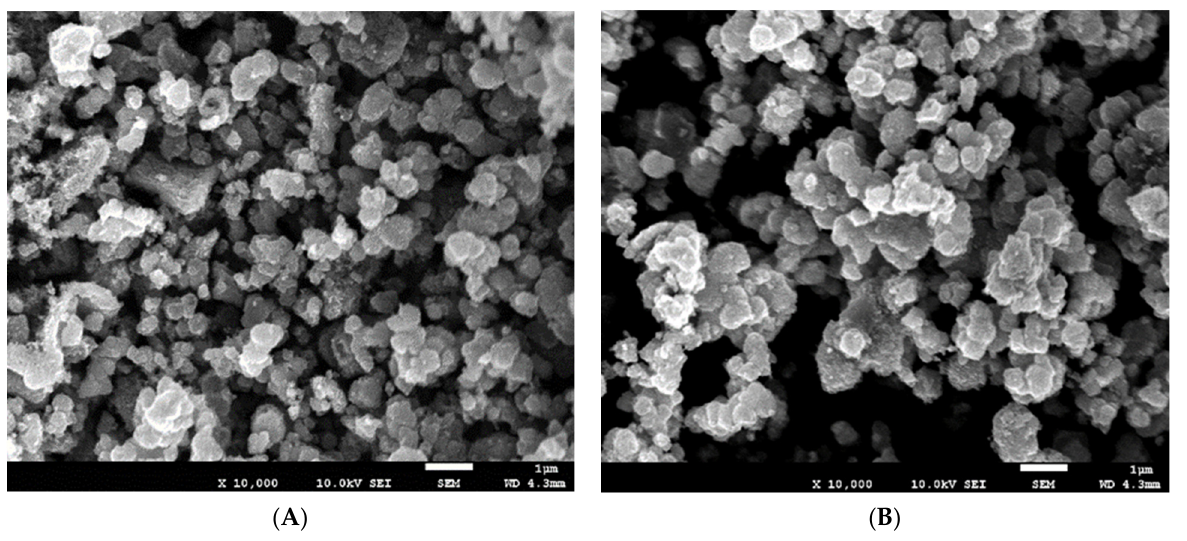
Figure 5. FESEM micrographs of ( A ) Welding waste sample and ( B ) GO.